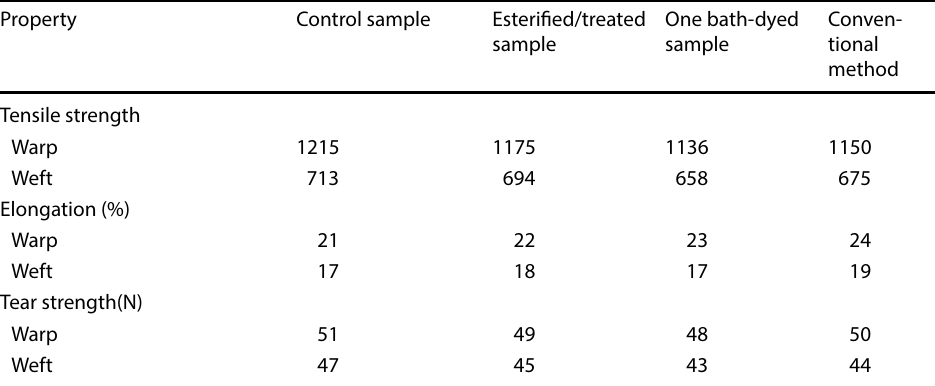
Table 10 Effect of treatment on physical properties of the